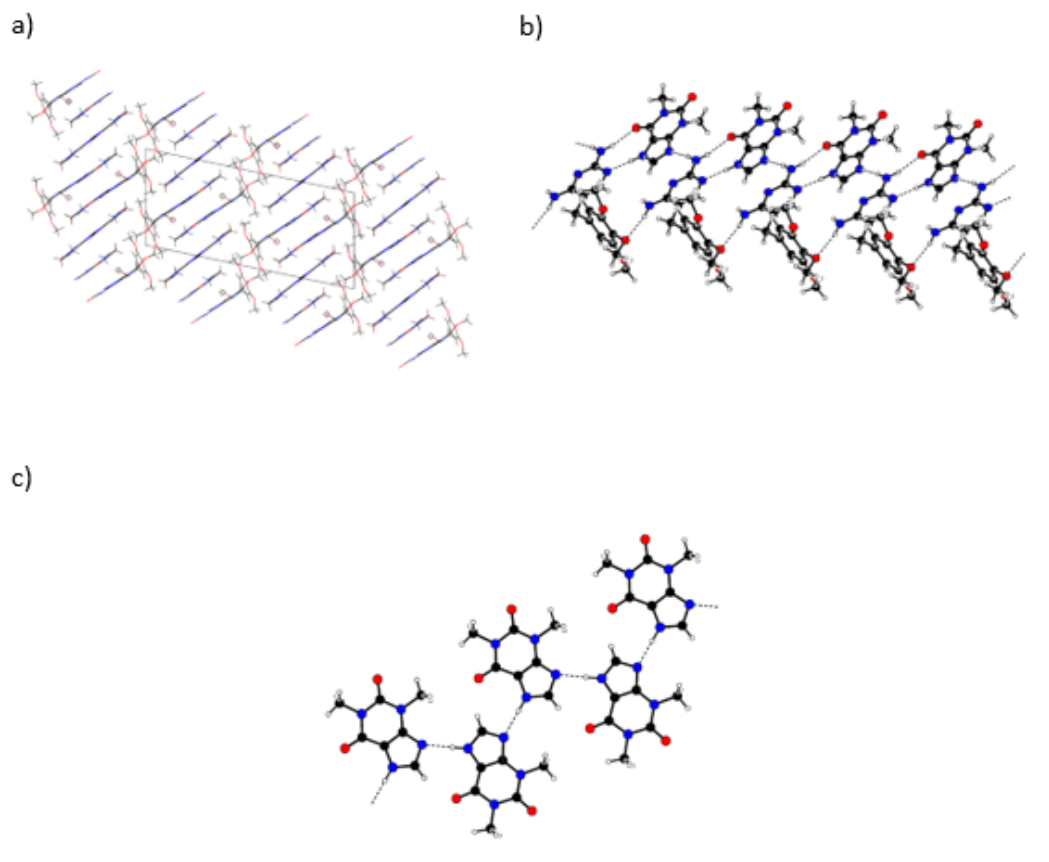
Figure 17. (1:2) trimethoprim:theophylline, CCDC 2109486: ( a ) Unit cell packing viewed along the b axis; ( b ) hydrogen bonded chains joining trimethoprim and theophylline molecules; ( c ) hydrogen bonded chains joining the second theophylline molecule .